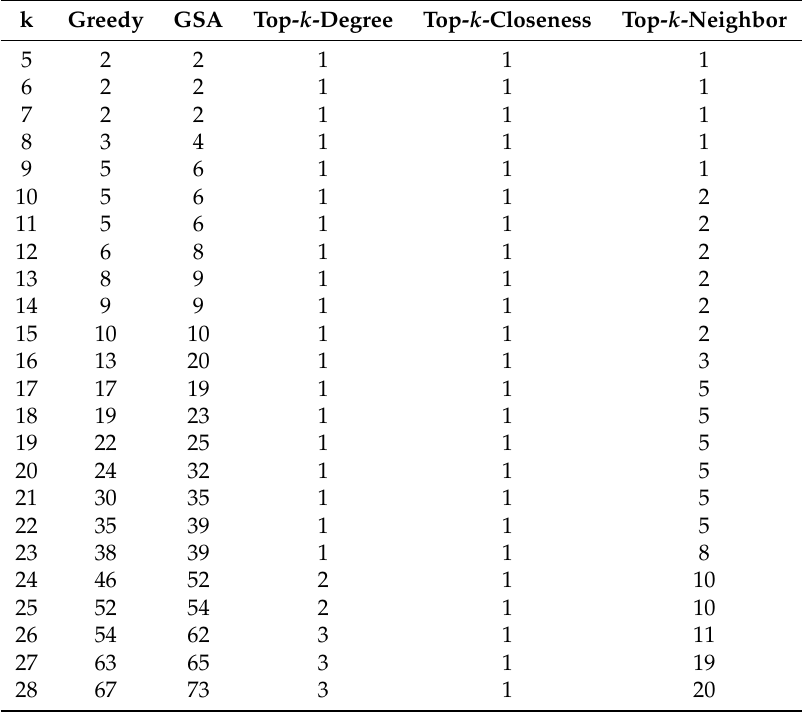
Table 8. The comparison of the approximate algorithm with the baseline algorithms: moreno-oz. k Greedy GSA Top- k -Degree Top- k -Closeness Top- k